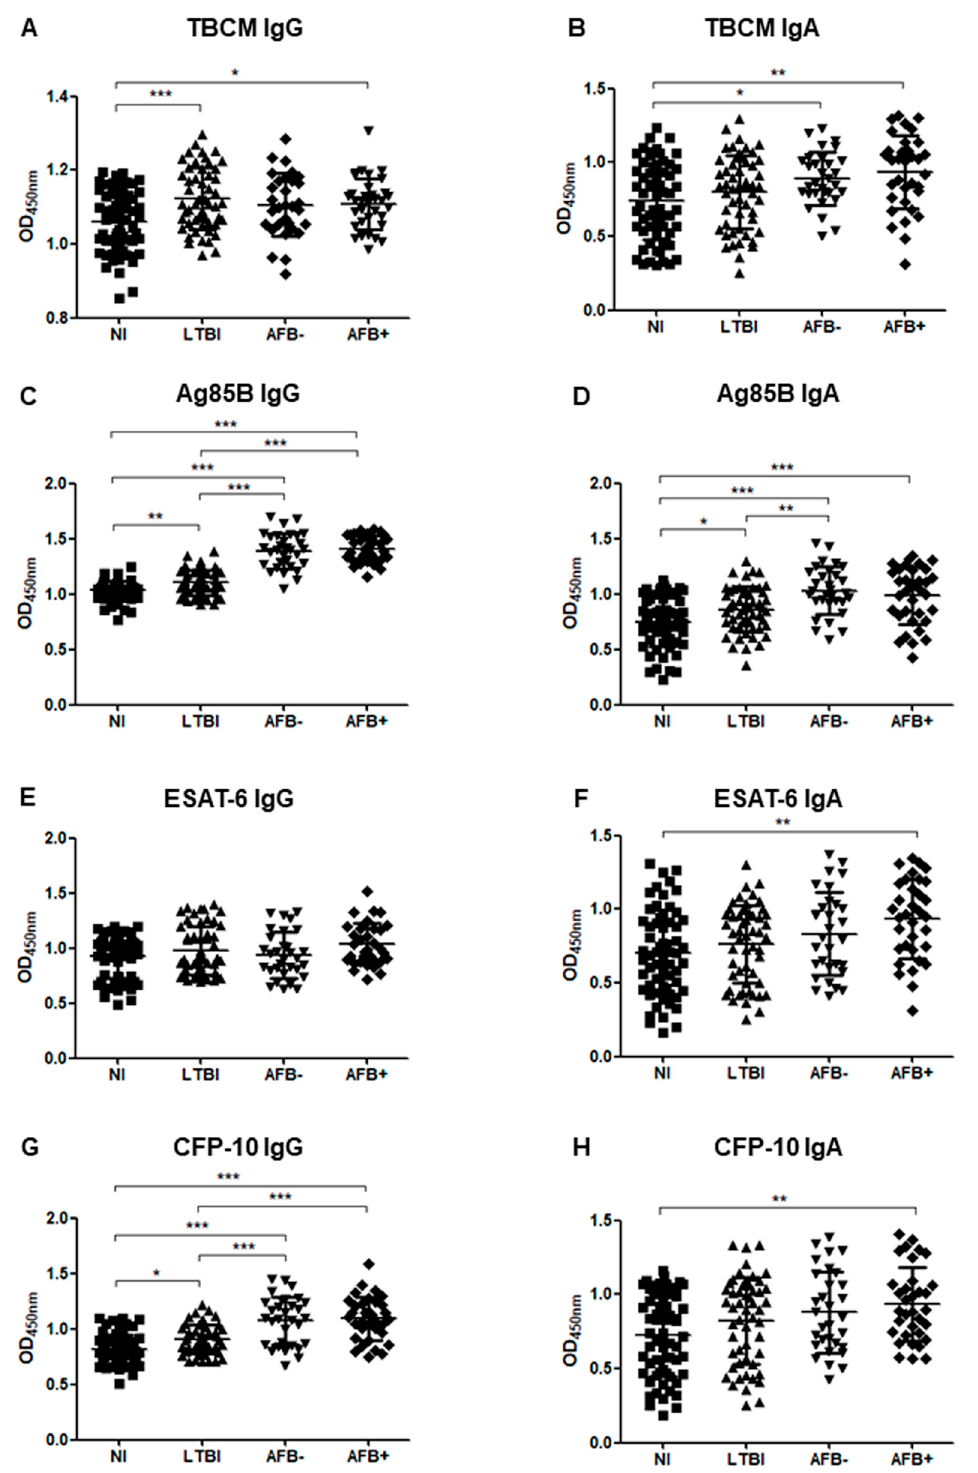
Figure 2. The optical density (OD) values of the anti-TBCM IgG ( A ), anti-TBCM IgA ( B ), anti-Ag85B IgG ( C ), anti-Ag85B IgA ( D ), anti-ESAT-6 IgG ( E ), anti-ESAT-6 IgA ( F ), anti-CFP-10 IgG ( G ), and anti-CFP-10 IgA ( H ) serodiagnosis assays for the comparison of 31 acid-fast bacilli (AFB)-negative tuberculosis (AFB-), 34 AFB-positive tuberculosis (AFB + ), 53 latent tuberculosis infection patients (LTBI), and 62 non-infected individuals (NI). Each dot represents the values obtained from individual subjects, and horizontal bars indicate the average values. Groups were compared by one-way ANOVA with Bonferroni’s multiple comparisons. * p < 0.05; ** p < 0.01; *** p < 0.001.